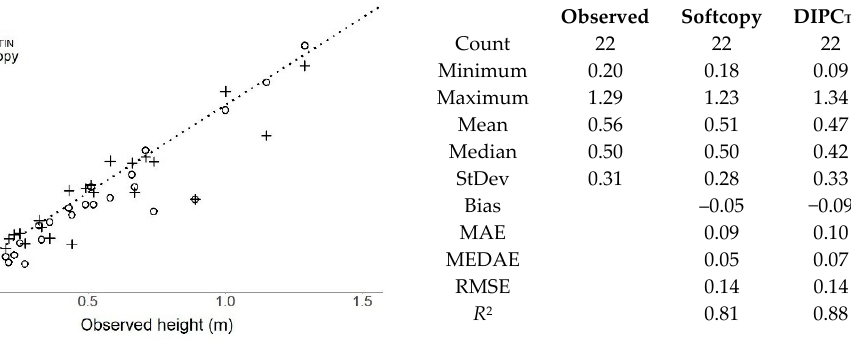
Figure 4. Scatterplot of observed (ground-measured) versus predicted heights for seedlings measured both with softcopy (crosses) and drone-based image point clouds (DIPC) (circles), including descriptive stats and accuracy metrics. DIPC TIN = ground elevation estimated the weighed mean elevation of the three closest nodes in the DIPC triangular irregular network; RMSE = root mean standard error; MAE = mean absolute error; MEDAE = median absolute error.